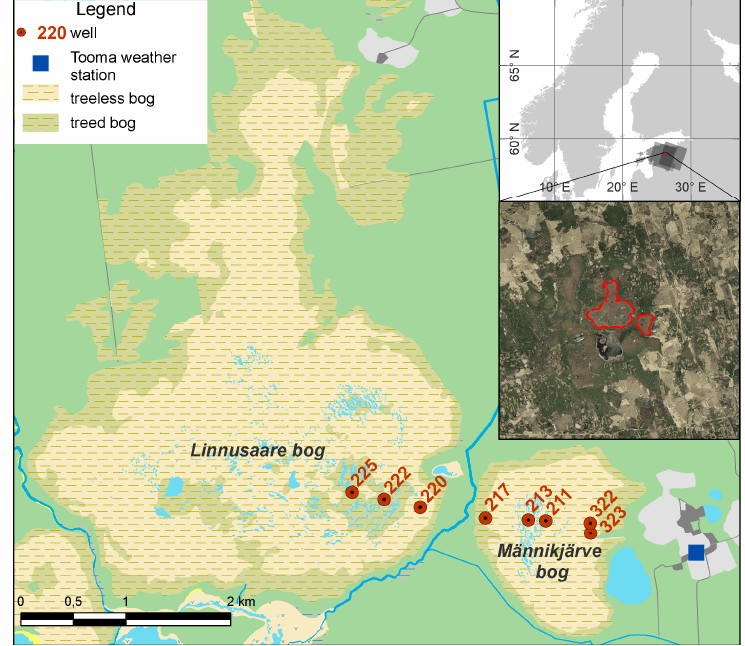
Figure 3. Base map showing the Linnusaare and Männikjärve bogs with (red circles) locations of water table measurement sites, (blue square) weather station, and (green shading) treed and treeless bog areas (designed by authors based on data from Estonian Topographic Database, Land Board 2020 [79]). The upper inset presents (dark grey) two overlapping Landsat scenes and (red square) the clipped area used in the modeling of trapezoids. The lower inset is a zoom of the clipped area and highlights the two bogs (red polygons).